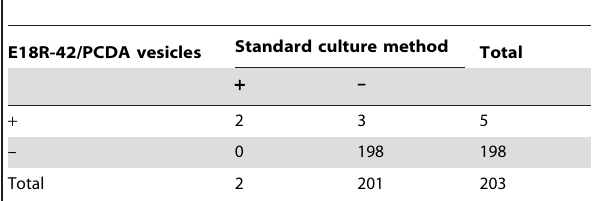
Table 2. Detection of E . coli O157:H7 in fecal samples by aptasensor and standard culture